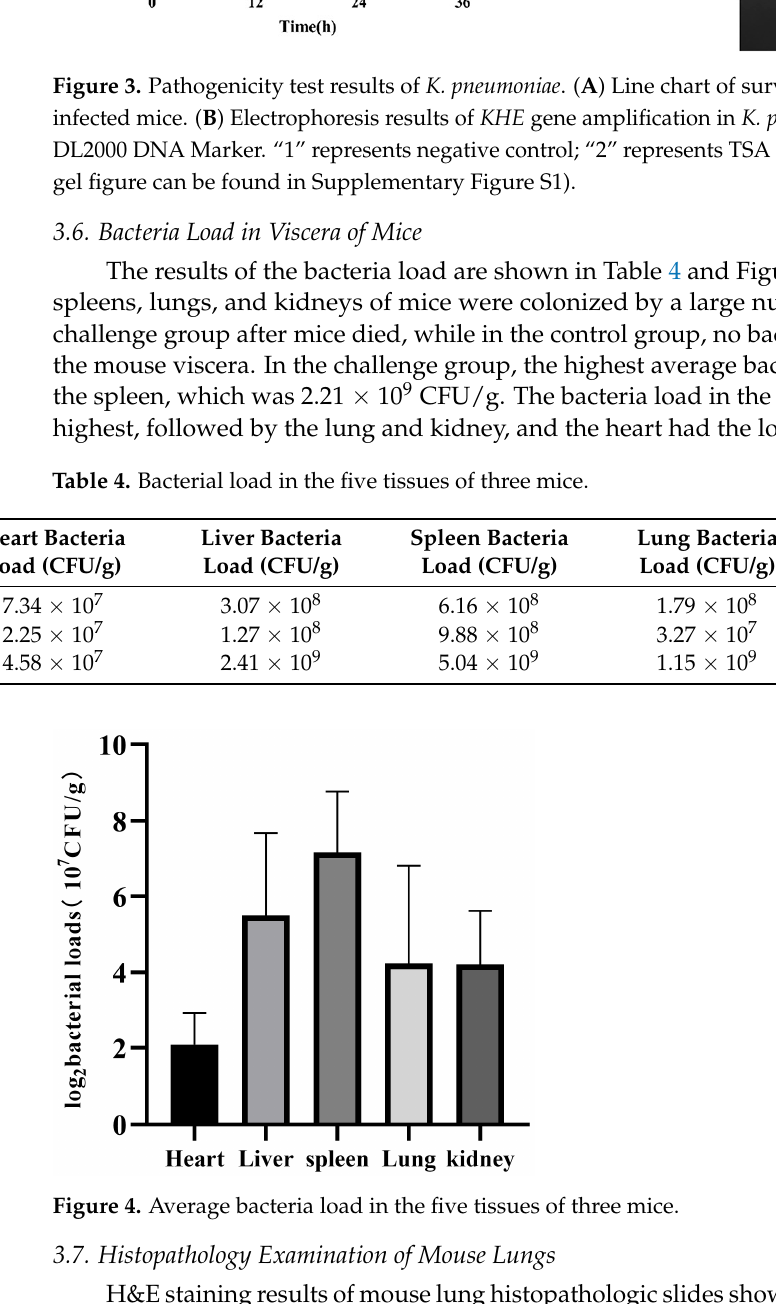
Figure 3. Pathogenicity test results of K. pneumoniae . ( A ) Line chart of survival rate of K. pneumoniae - infected mice. ( B ) Electrophoresis results of KHE gene amplification in K. pneumoniae . “M” repre- sents DL2000 DNA Marker. “1” represents negative control; “2” represents TSA single colony (The original gel figure can be found in Supplementary Figure S1).